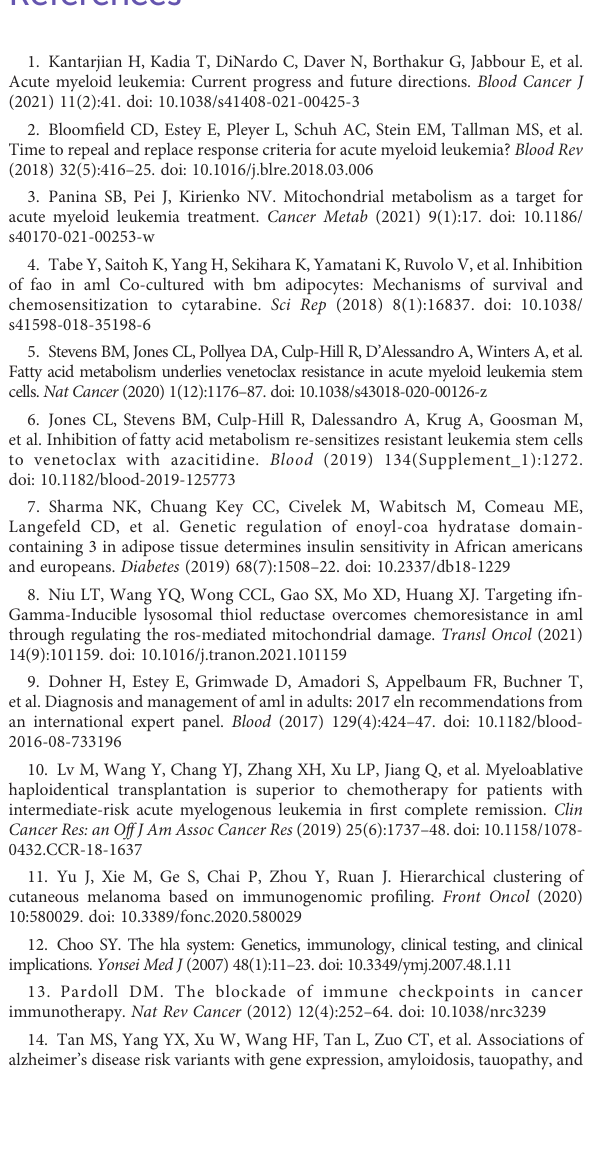
SUPPLEMENTARY FIGURE 4 Immune landscape between ECHDC3 high and ECHDC3 low groups (A) The heat map visualized the percentage abundance of tumor-in fi ltrating immune cells in each sample. (B) Immune cell in fi ltration correlation matrix. (C) Correlation matrix of all 22 immune cell